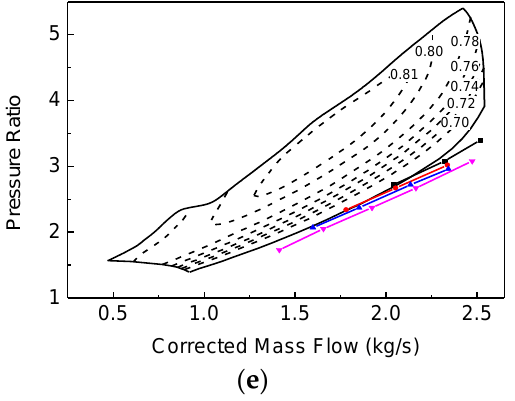
Figure 7. Variations of the main engine parameters at 1800 r/min with the 1TC. ( a ) intake pressure. ( b ) the maximum combustion pressure. ( c ) difference between the intake and exhaust pressures. ( d ) brake specific fuel consumption. ( e ) compressor.